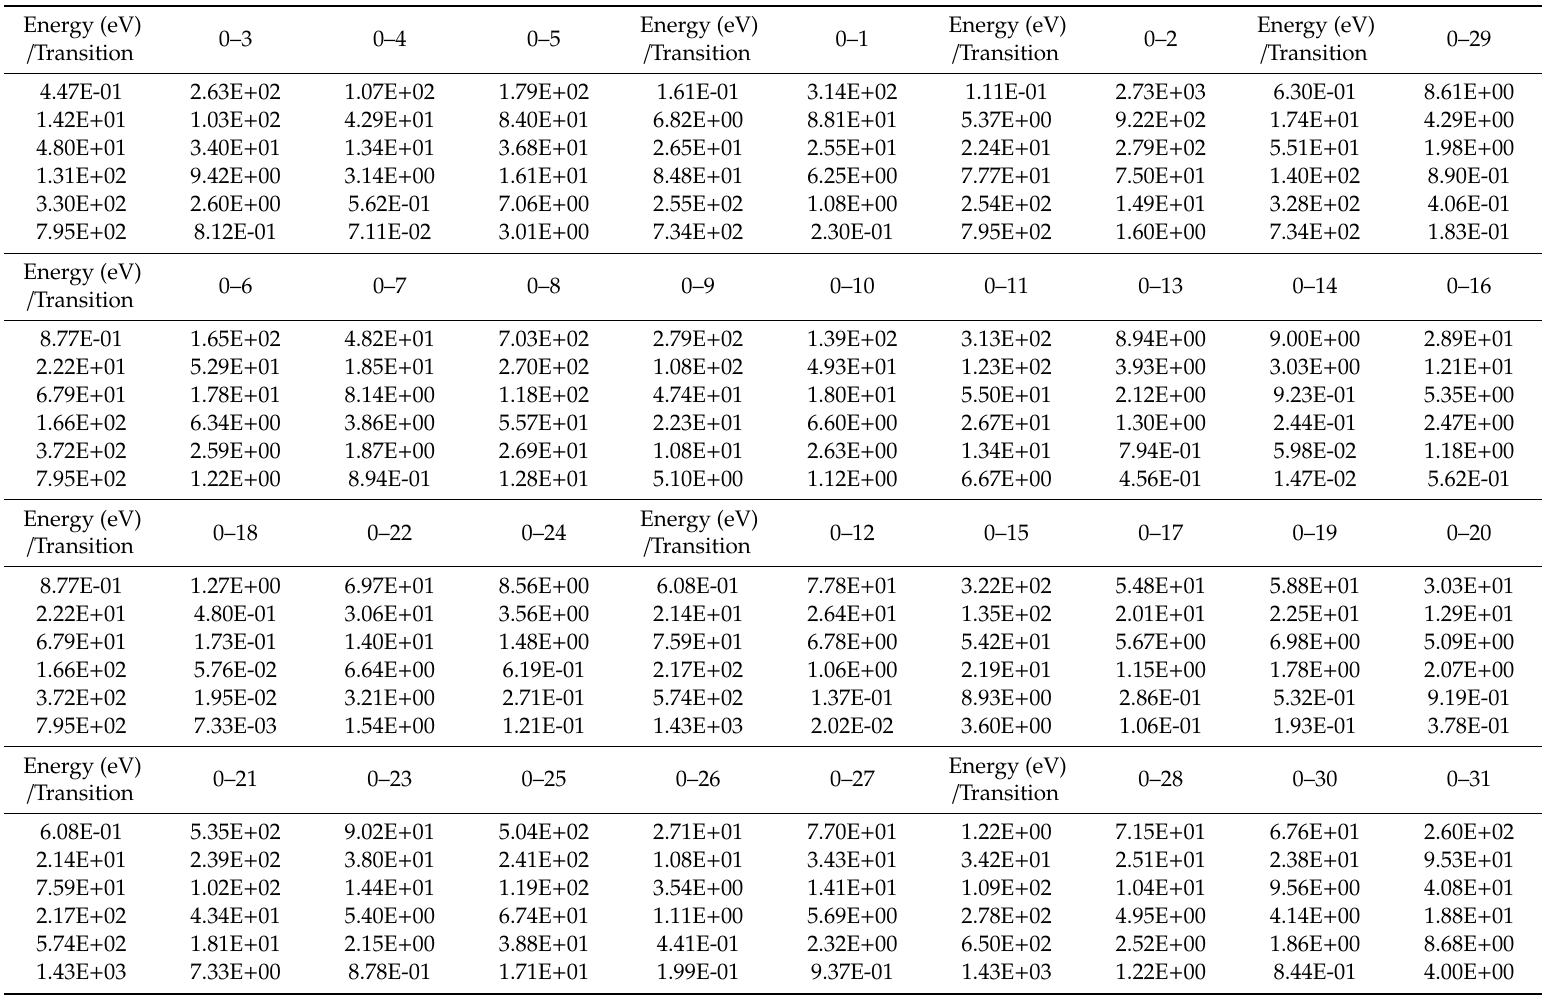
Table 6. Collisional excitation cross-sections (100 Mb) of Eu-like W from the ground state to various